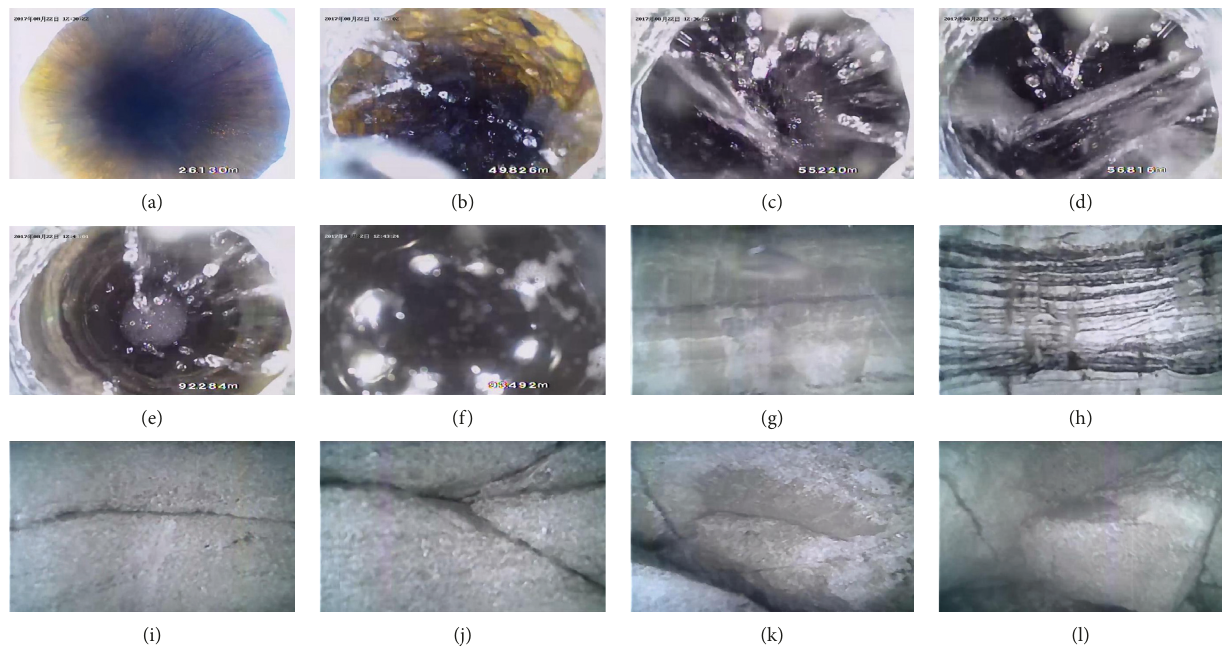
Figure 17: Television observation results of boreholes in exploration area